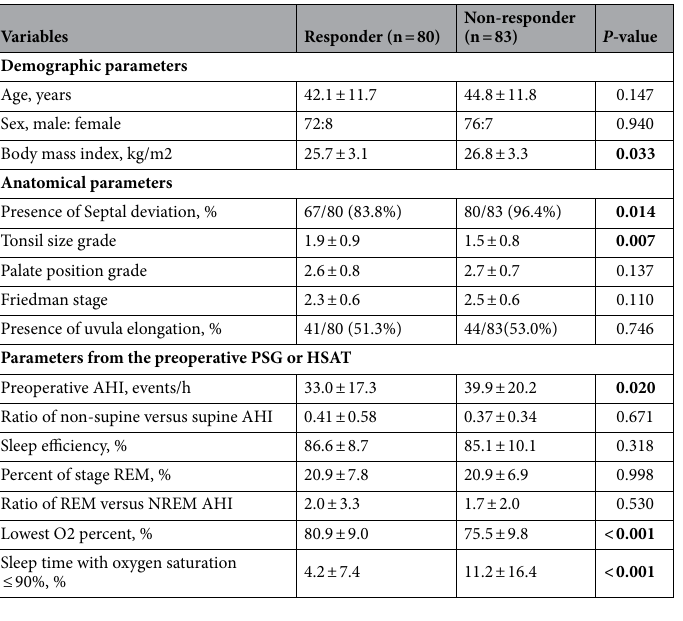
Table 2. Comparison of clinical parameters between responder and non-responder groups. Bold values indicates statistical significance ( P < 0.05). AHI, apnea hypopnea index; REM, rapid eye movement; NREM, non-rapid eye movement. Values are presented as mean ± SD or numbers (percentages).